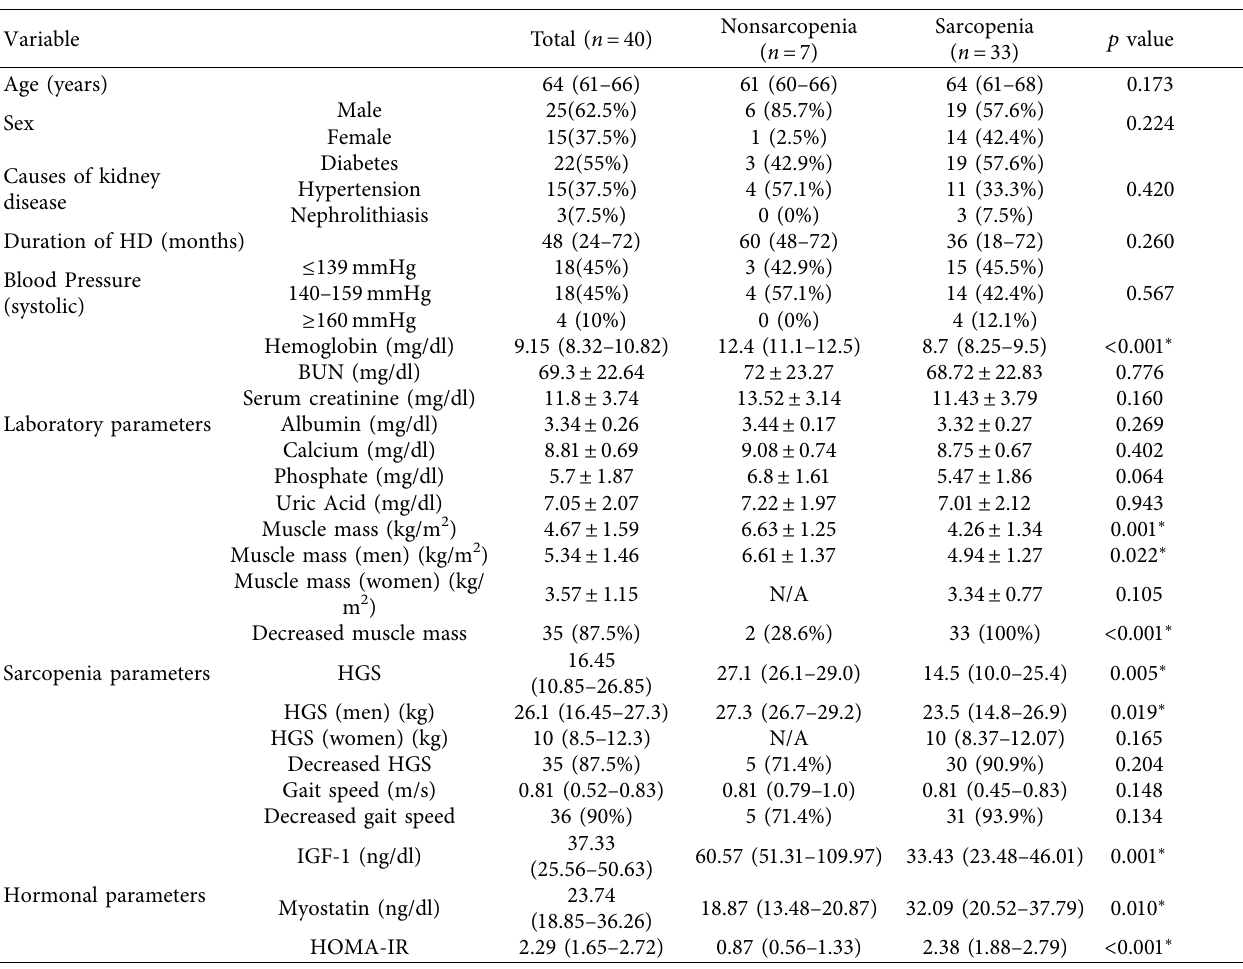
Table 1: Characteristics of